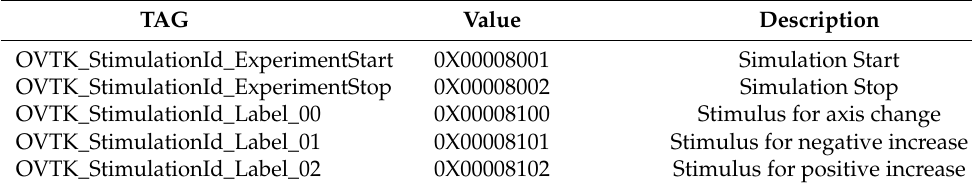
Figure 9. Control signal flowchart. Table 1. VRPN communication tags.